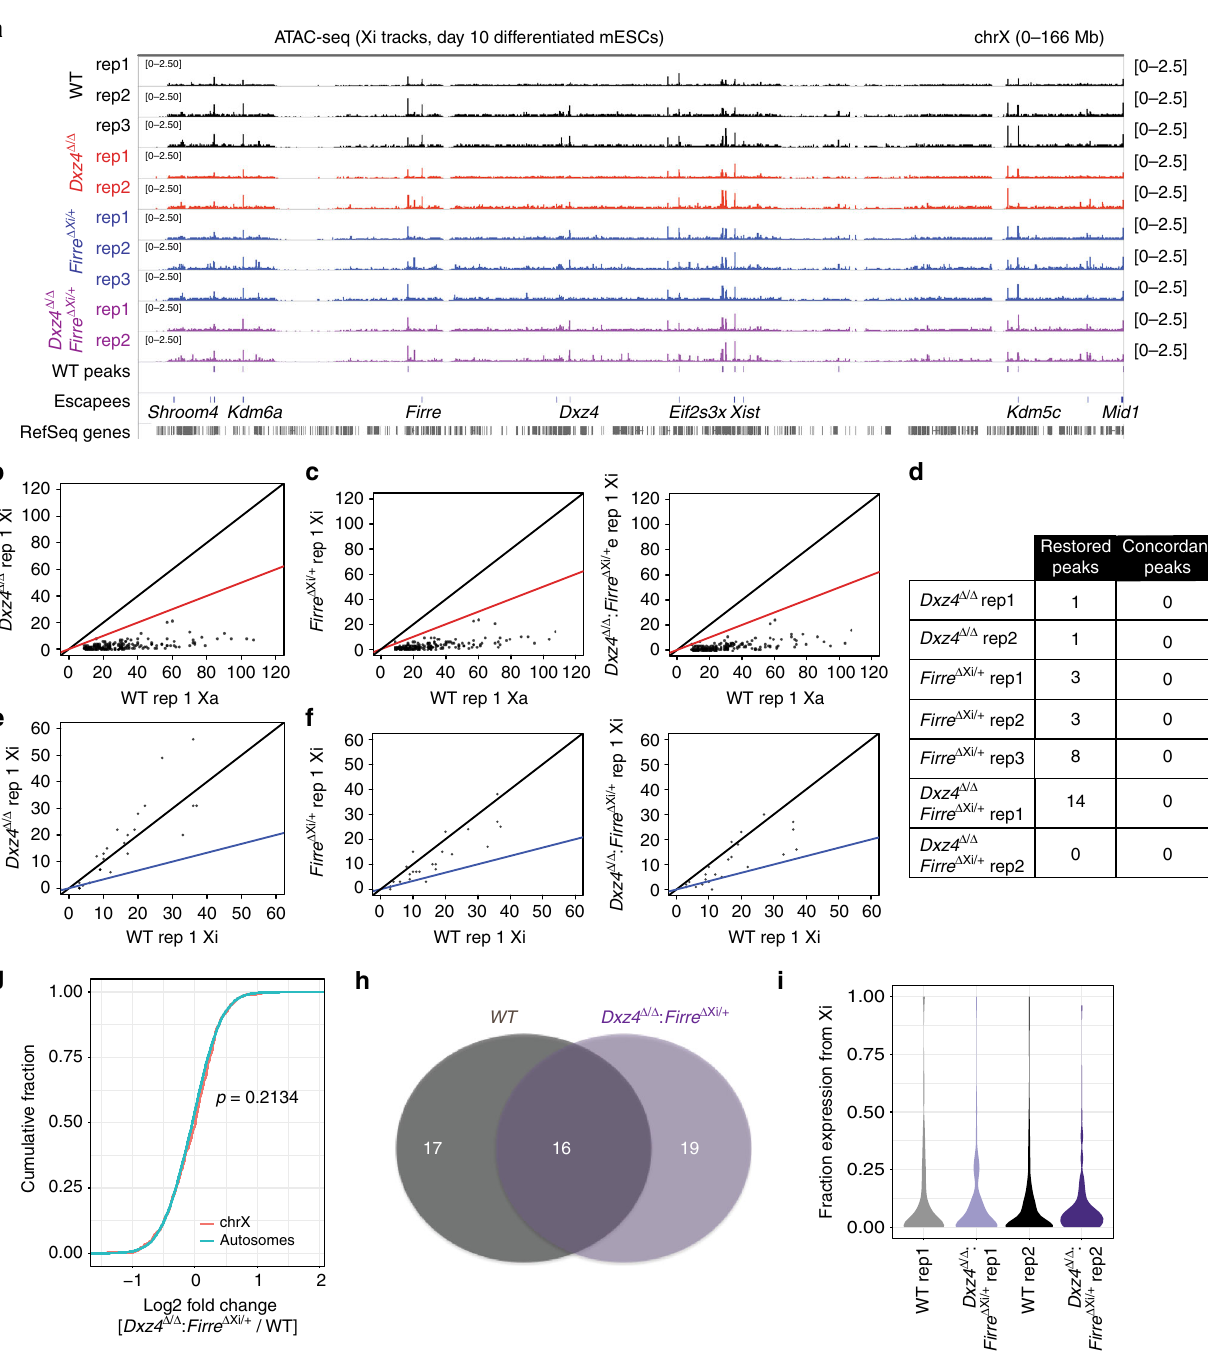
Fig. 8 Accessibility and gene silencing on the Xi in the Dxz4 and Firre deletions. a Comparison of Xi ATAC-seq coverage, WT (black), Dxz4 Δ / Δ , Firre Xi Δ / + (blue) and Dxz4 Δ / Δ : Firre Xi Δ / + (purple). b Comparison between WT Xa and Dxz4 Δ / Δ Xi ATAC coverage for peaks that are Xa-speci fi c in wild-type. The black line corresponds to a Dxz4 Δ / Δ Xi:WT Xa ratio of 1:1, the red line corresponds to a ratio of 1:2. c Comparison between WT Xa and Firre Xi Δ / + (left) or Dxz4 Δ / Δ : Firre Xi Δ / + (right) Xi ATAC coverage for peaks that are Xa-speci fi c in wild-type. The black line correspond to a Dxz4 Δ / Δ Xi:WT Xa ratio of 1:1, the red lines correspond to a ratio of 1:2. d Number of restored ATAC peaks (Xa-skewed in wild-type but biallelic in deletion) for all deletions. Concordant peaks are peaks reproducibly restored across replicates. e Comparison between WT Xi and Dxz4 Δ / Δ Xi ATAC coverage for peaks that are Xi-speci fi c in wild-type. The black line corresponds to a Dxz4 Δ / Δ Xi:WT Xi ratio of 1:1, the blue line corresponds to a ratio of 1:2. f Comparison between WT Xi and Firre Xi Δ / + (left) or Dxz4 Δ / Δ : Firre Xi Δ / + (right) Xi ATAC coverage for peaks that are Xi-speci fi c in wild-type. The black lines correspond to a Dxz4 Δ / Δ Xi:WT Xi ratio of 1:1, the blue lines correspond to a ratio of 1:2. g CDF of the fold change in gene expression between WT and Dxz4 Δ / Δ : FirreXi Δ / + for autosomal genes (teal) and X-linked genes with fpm > 1 in all experiments. The Kolmogorov – Smirnov p -value is indicated. h Overlap between escapees in WT and Dxz4 Δ / Δ : Firre Xi Δ / + . i Density plots of the number of genes with a given level of expression from the Xi in two wild-type and two Dxz4 Δ / Δ : Firre Xi Δ / + replicate RNA-seq experiments. Grey and black: wild-type, purple: Dxz4 Δ / Δ : Firre Xi Δ /